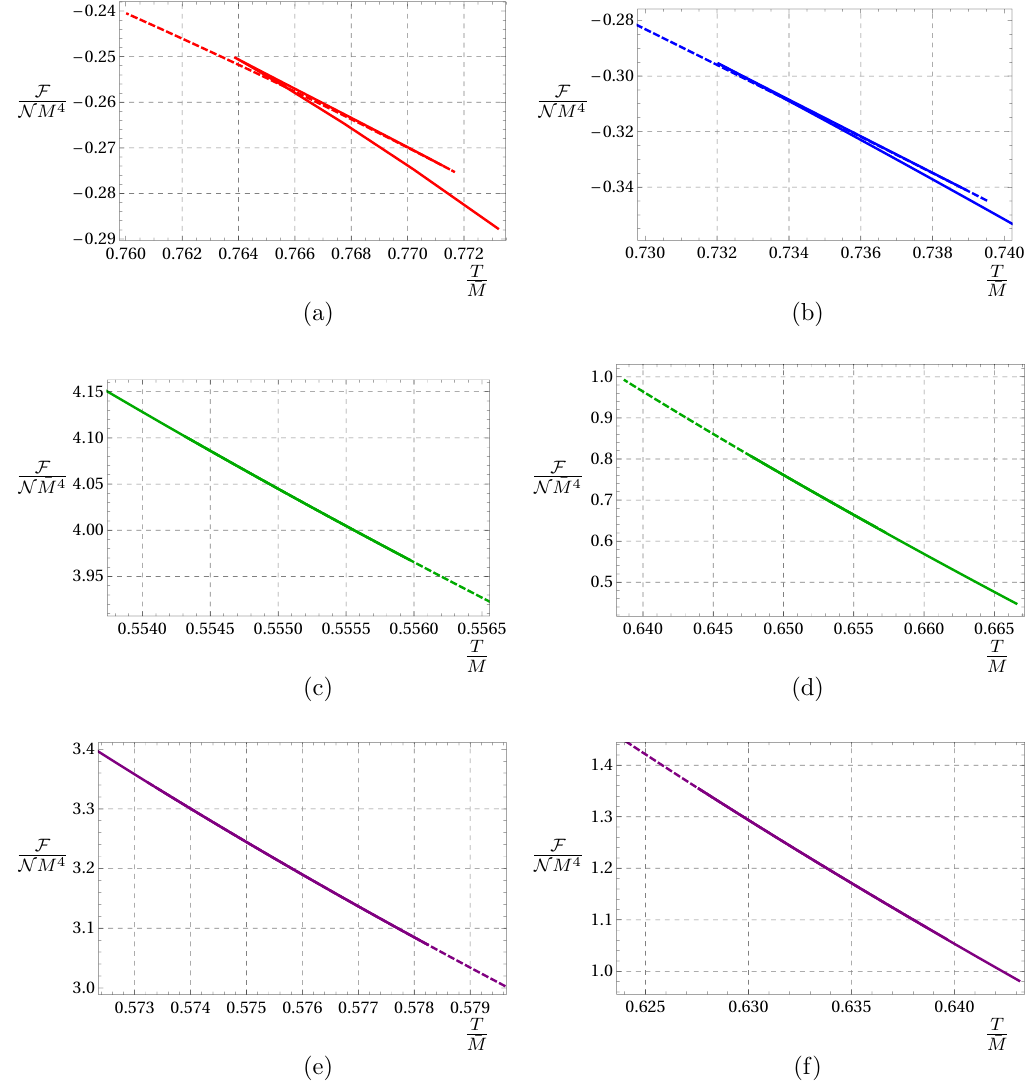
Figure 8 . Zoom into the transition region between Minkowski and black hole embeddings for the free energy density. The values of the magnetic (cid:12)eld are b= (cid:22) M 2 = 0 (a), 2 (b), 3.3 (c) and (d), and 3.4 (e) and (f). Dashed lines represent Minkowski embeddings, whereas solid lines represent black hole